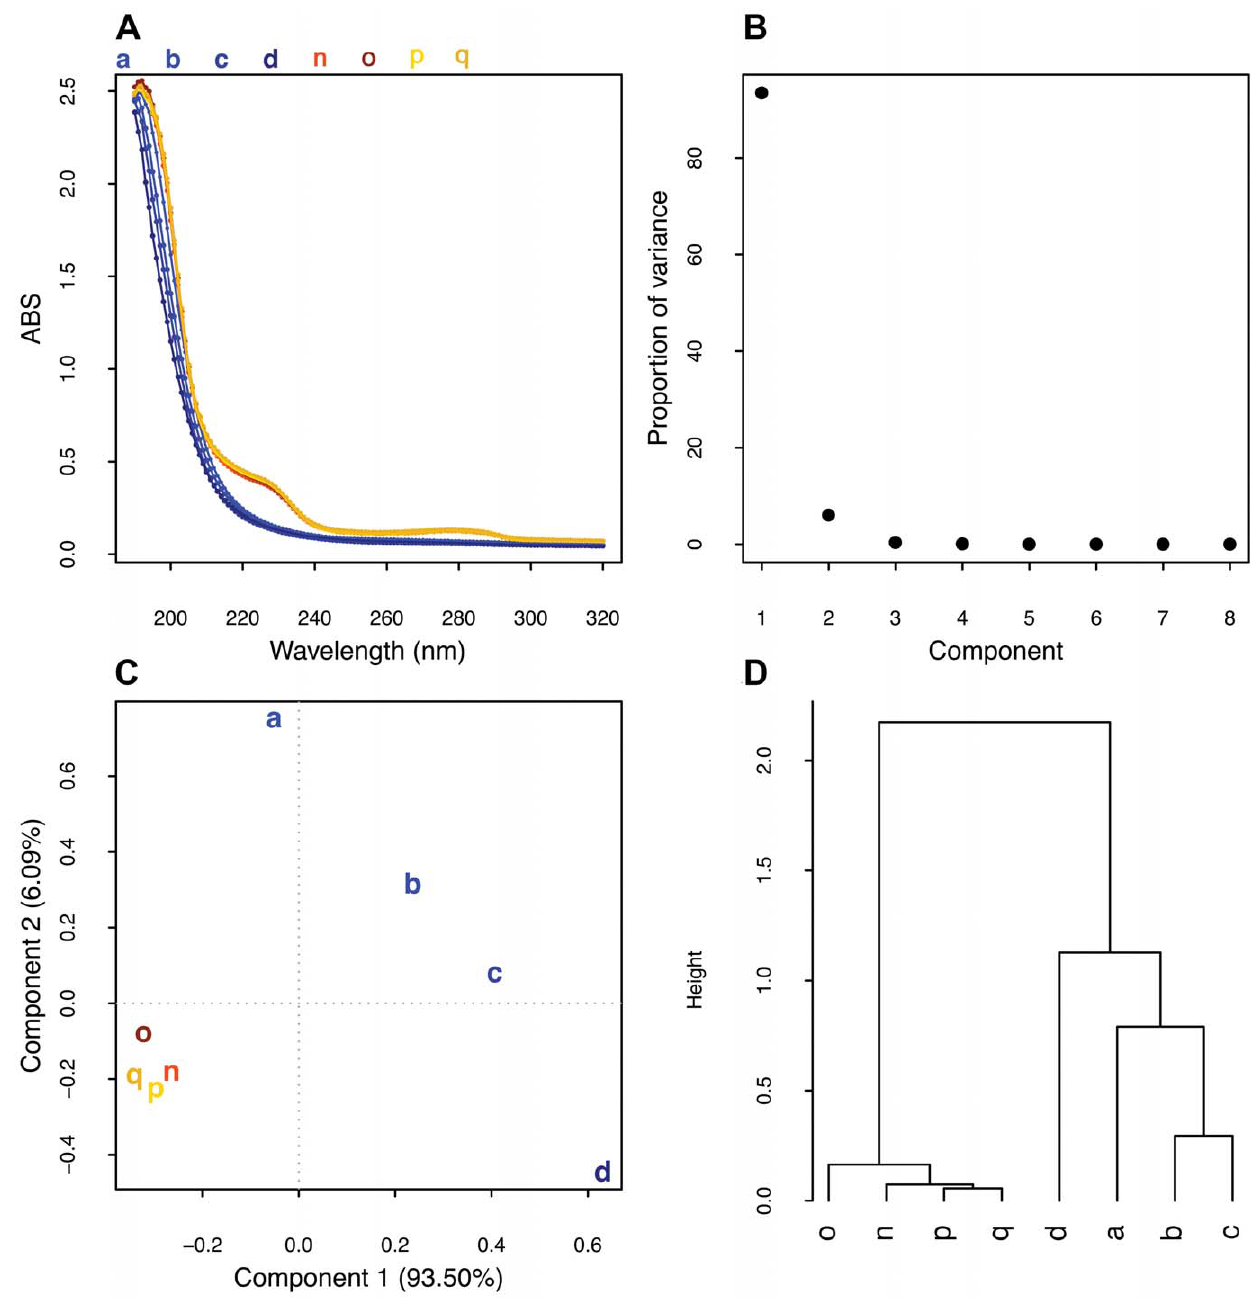
Figure 4. Multivariate analysis of UV spectra of heparin spiked with non-mammalian polysaccharides. ( A ) Overlay of heparin preparations scanning UV spectra. ( B ) Scree plot of components. ( C ) Component plot. ( D ) Hierarchical cluster analysis performed on the loading plot. Samples a–d represent pure heparin samples; n–p correspond to heparin spiked with 5 and 10% of SA respectively; g–h are heparin spiked with 5 and 10% of SG.